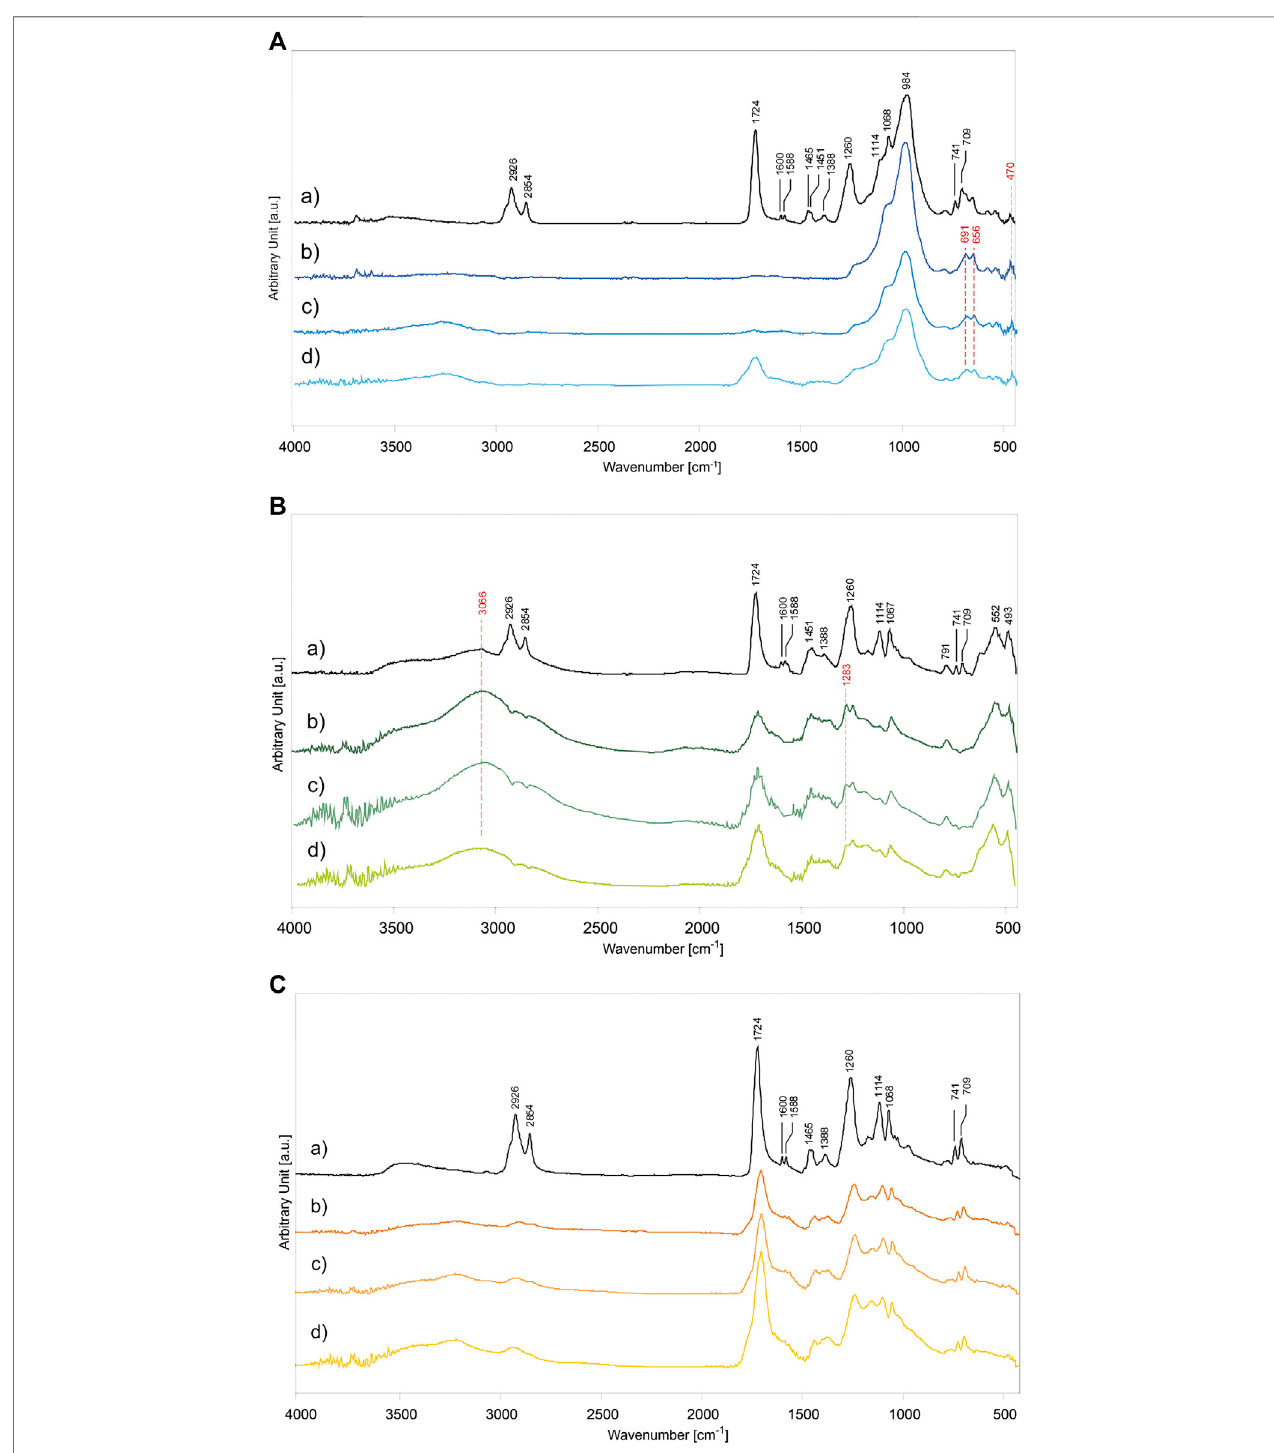
FIGURE6| ATR-FTIR spectraofalkydbinder inmixture withinorganicpigments: (A) PB29, (B) PG18, and (C) PY37.The graphsofpaint mixtures are, (a) unaged P/BM 1:2, and after 1,008 h of UV exposure according to different P/BM ratio: (b) 1:2, (c) 1:3, and (d) 1:6.